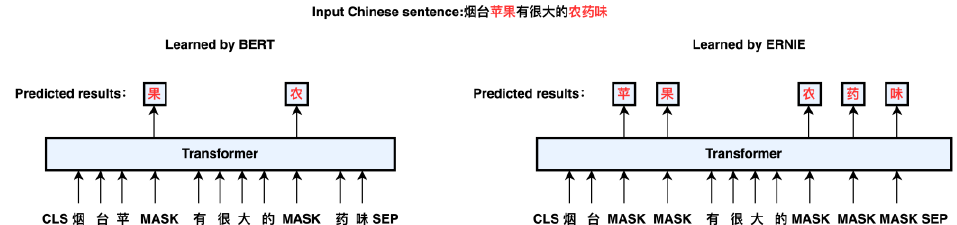
Figure 1. Comparison of learning methods between BERT and ERNIE model. ERNIE learns the se‑ mantic representation of complete concepts by masking Chinese characters and entities (“ 苹果 ” and “ 农药味 ”), while BERT learns the semantic representation by masking individual Chinese characters (“ 果 ” and “ 农 ”).